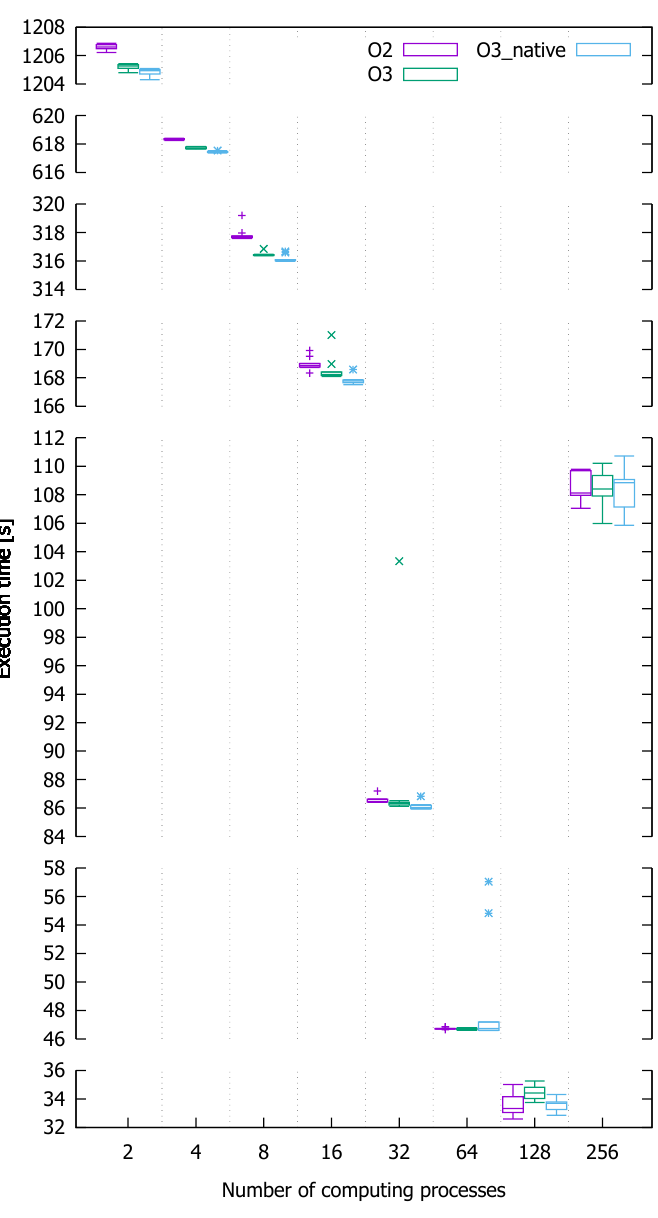
Figure 12. Execution times for SPMD, for better of Docker and host versions; boxplot notation: medi- ans, Q1 and Q3, max(Q1 − 1.5IQR, minimum) and min(Q3+1.5IQR, maximum) as well as potential outliers (+ for O2, x for O3, * for